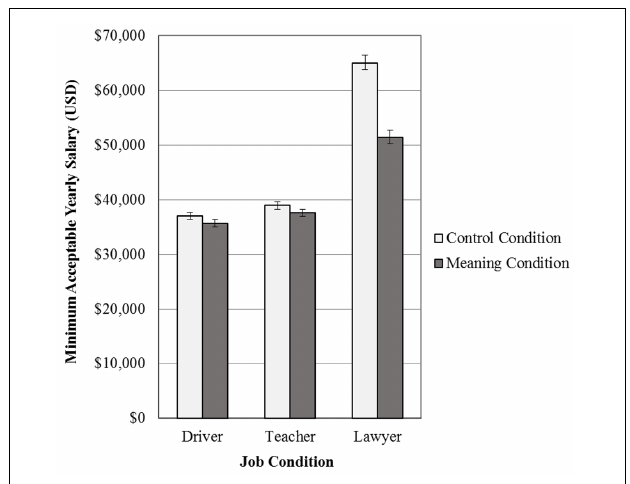
FIGURE 2 | Average minimum acceptable salaries for each of the job and meaning conditions in Study